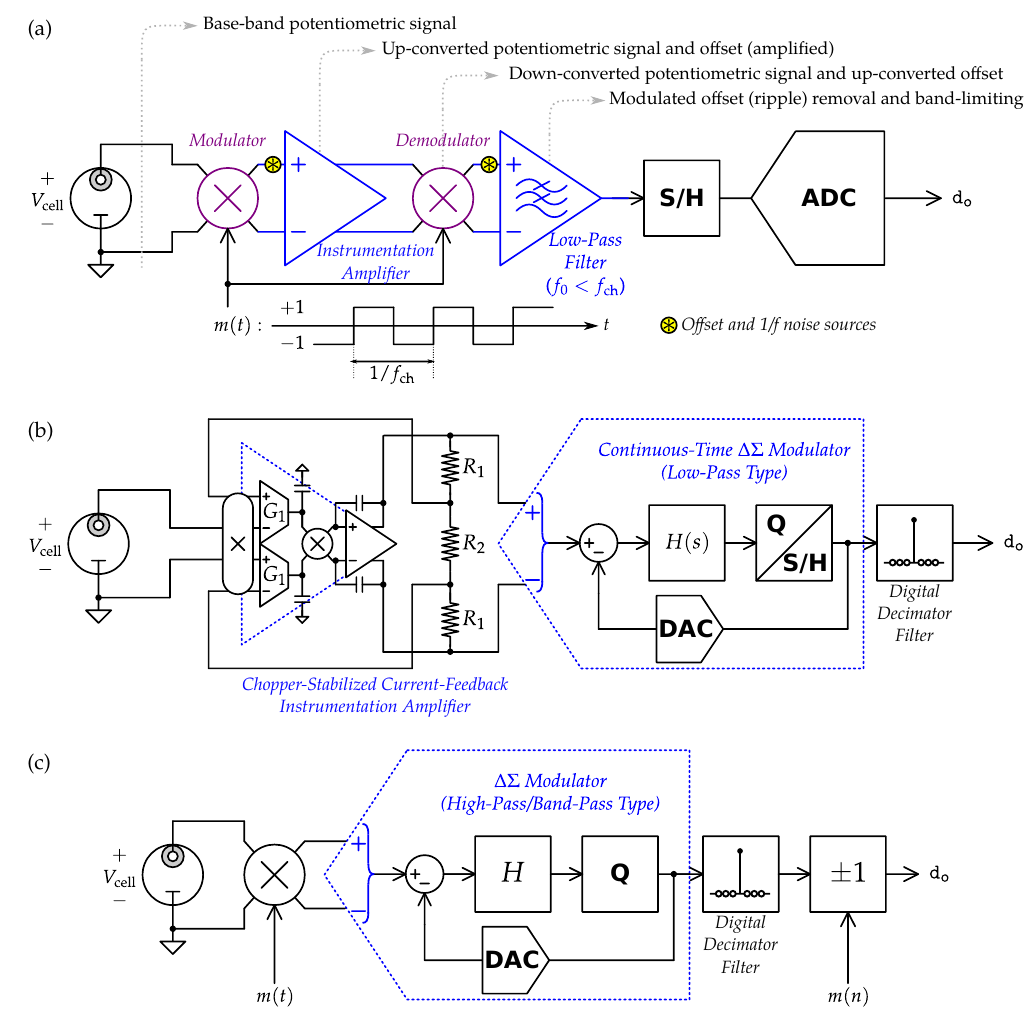
Figure 8. Readout chain variants for potentiometric signals: ( a ) classic chopper-stabilized redout chain; ( b ) improved by means of a modified current–feedback instrumentation amplifier; ( c ) based on early digitalization and system-level chopper